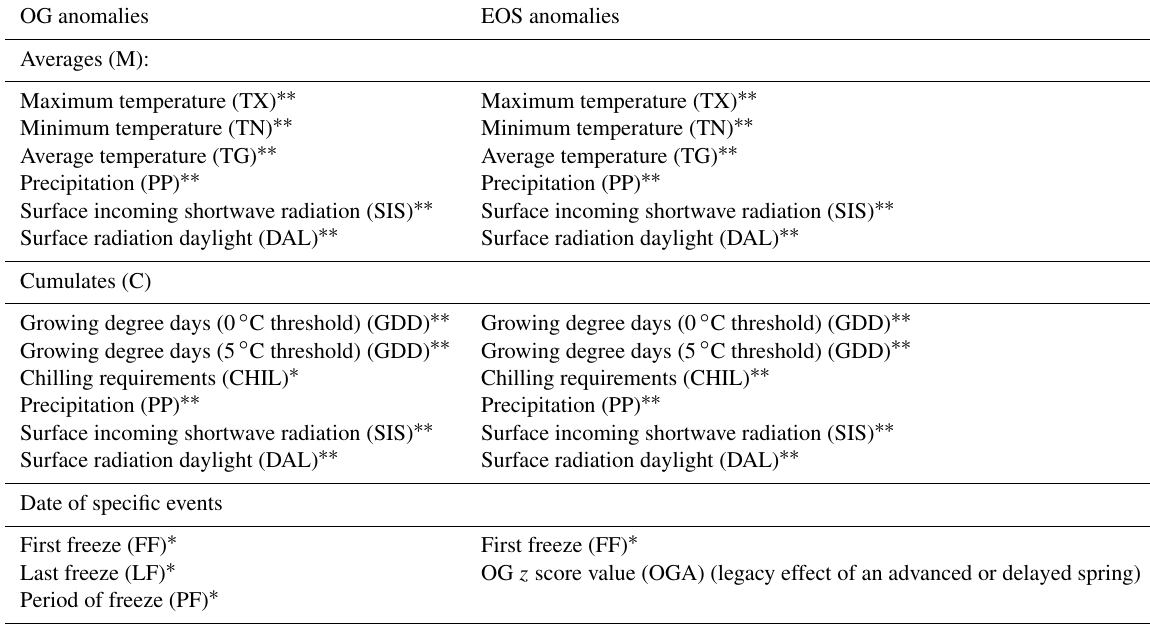
Table 1. Predictors used in the modelling of the interannual variation in LSP. OG anomalies EOS